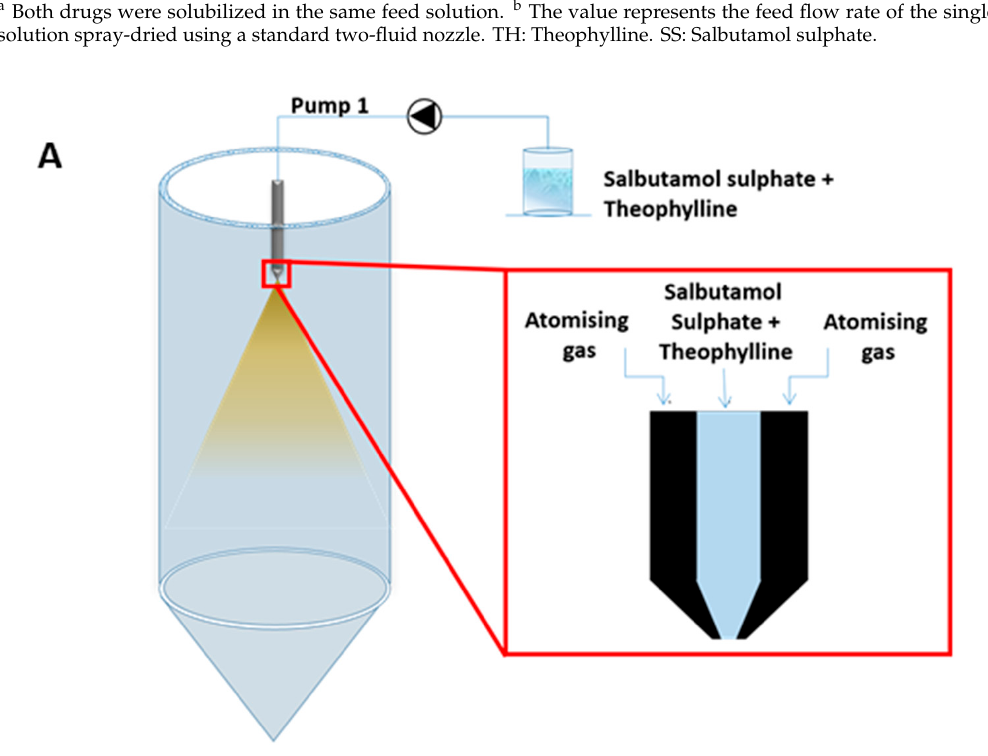
Figure 1. Schematic representation of ( A ) the two-fluid nozzle and ( B ) the three-fluid nozzle.